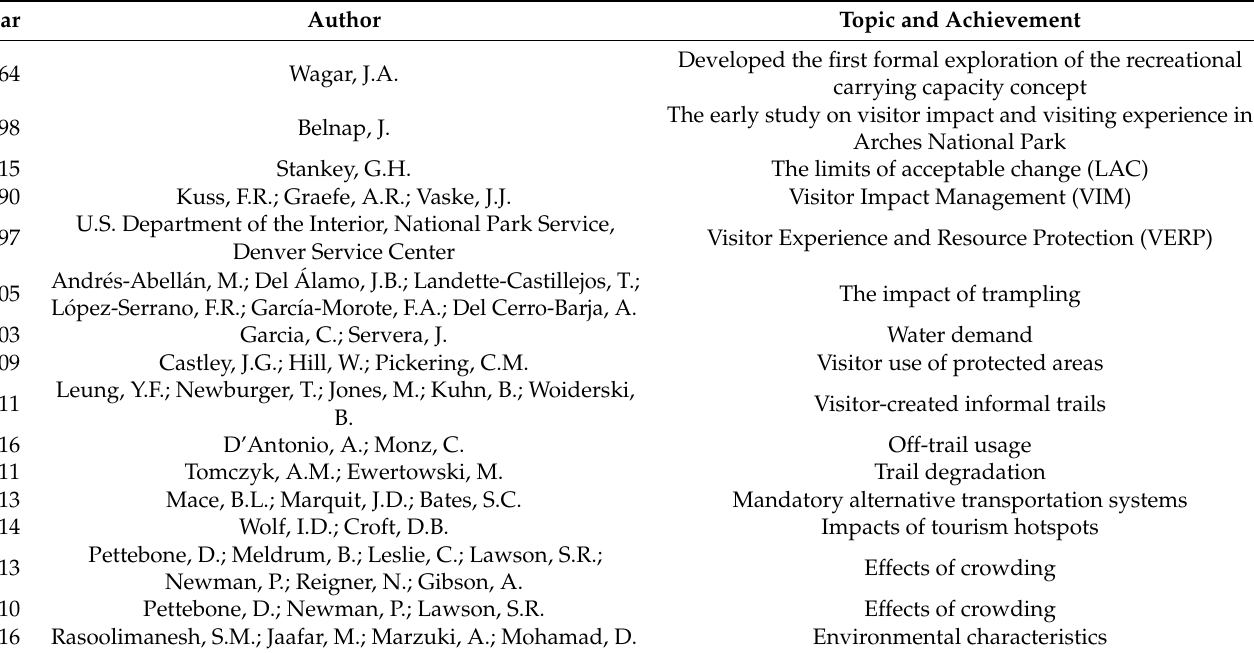
Table A1. Important citations of park